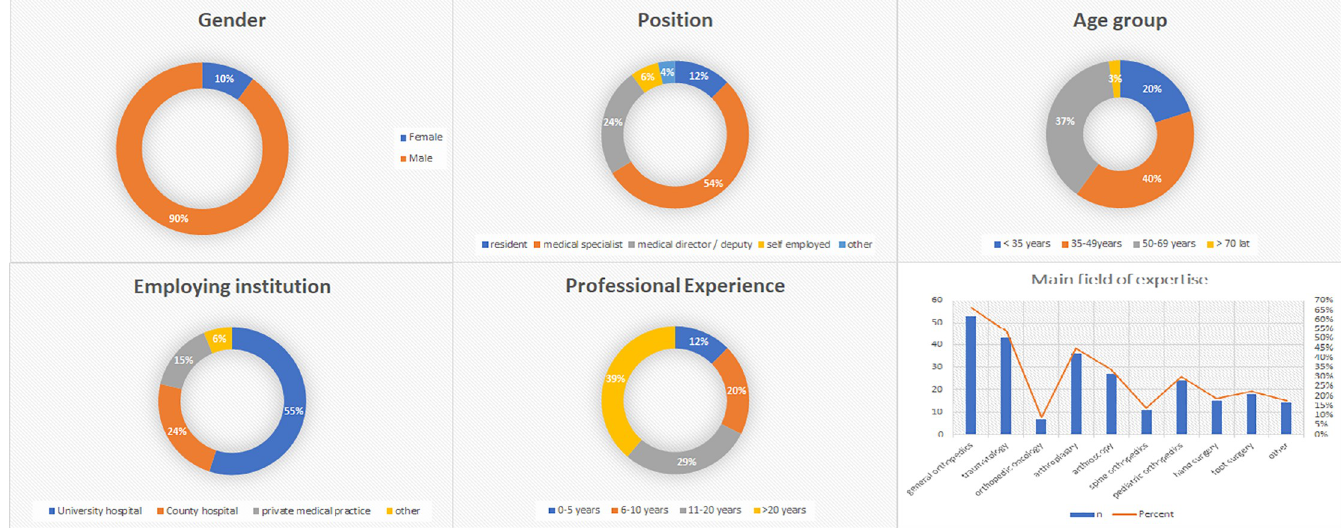
Fig 1. General description of the study group. The graphs show the composition of the participants’ profile information. Summarizes gender, position, age, employing institution, professional experience, and main field of experience.